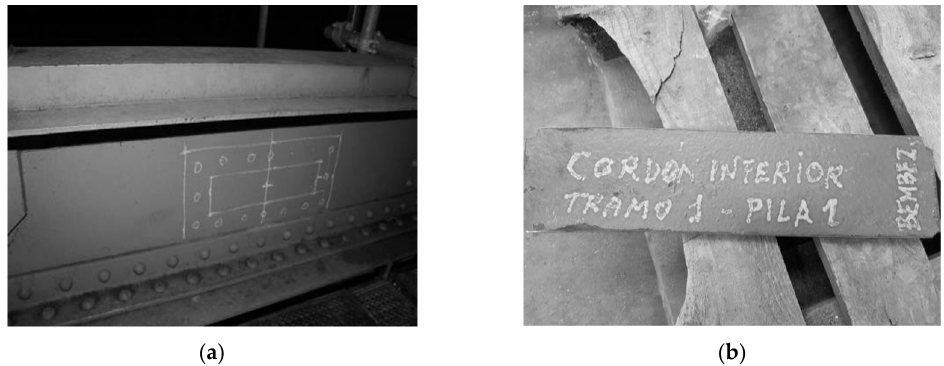
Figure 7. ( a ) Sample position example from the “Bembézar” bridge; ( b ) Sample example after extraction from the “Bembézar” bridge.